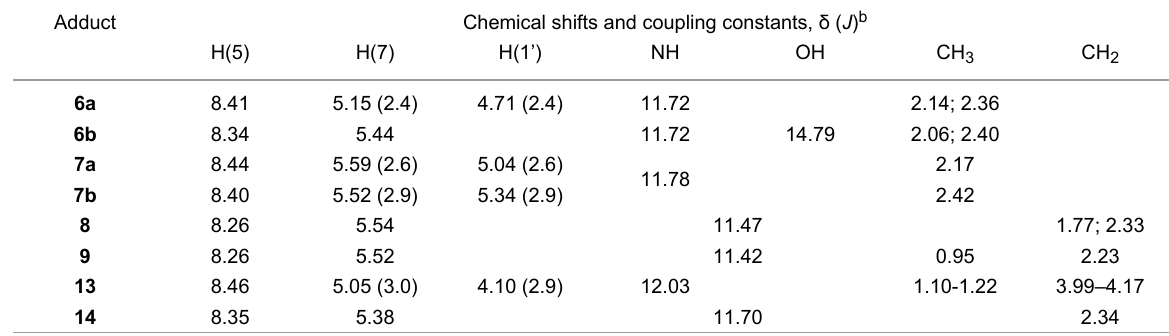
Table 2: Selected NMR parameters of the ANBF-CH-acid adducts (in DMSO- d 6 ) a . Adduct